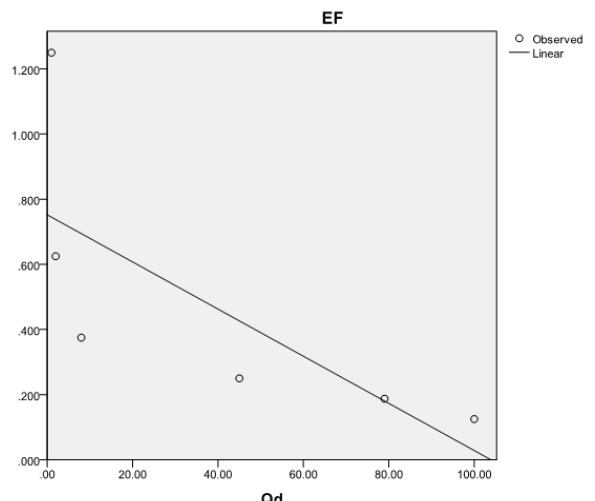
Fig. 3. Demand curve indicating quantity demanded (Qd) at different entrance fee